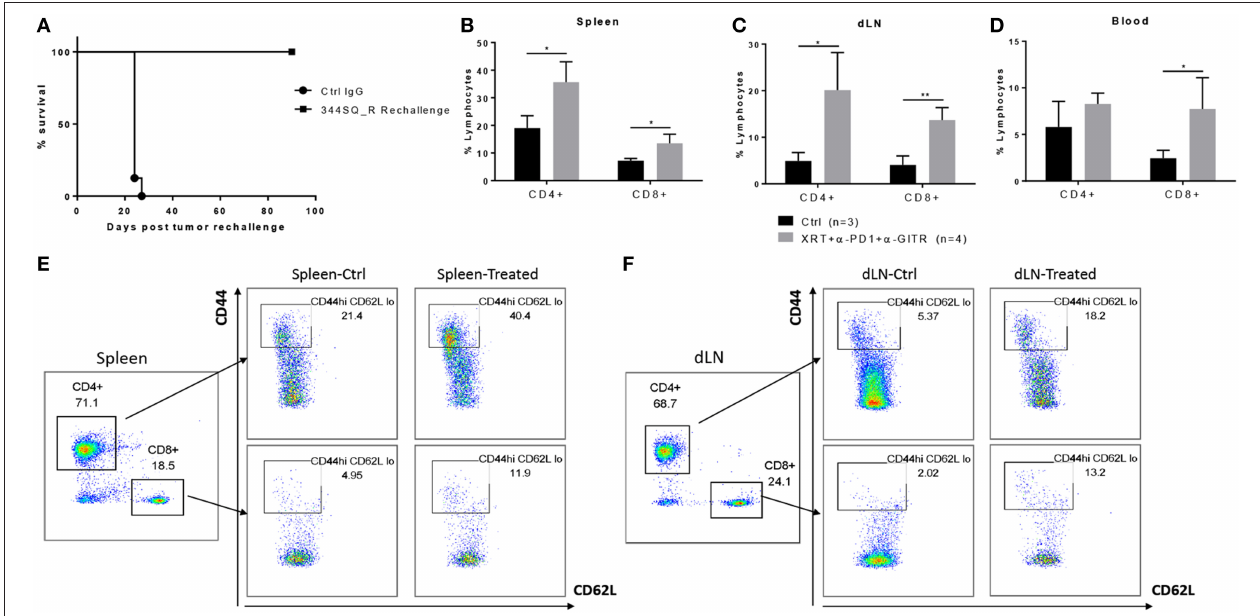
FIGURE 2 | Long term effector memory is established in 129Sv/Ev mice challenged with 344SQ_R tumors and treated with XRT + anti-PD1 + anti-GITR. Mice previously treated with triple therapy who had total resolution of tumors ( n = 4) were rechallenged with 1 × 10 6 344SQR cells at the abscopal site and compared with control mice ( n = 3), prevously treated with Ctrl IgG. (A) Survival of rechallenged mice vs. controls. CD4 and CD8 T-cells from (B) spleen (C) secondary tumor draining lymph node and (D) peripheral blood are analyzed 90 days after the secondary abscopal tumor clearance. (E, F) Cells are gated on CD3 + then on CD44 hi and CD62L low population. * P ≤ 0.05; ** P ≤ 0.01 in Student t